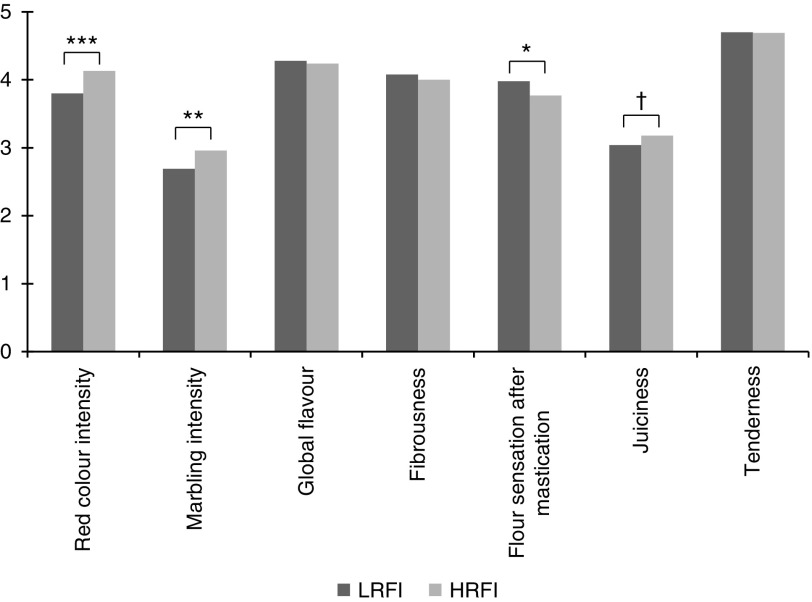
Sensorial meat quality in the loin evaluated on a 0 to 10 scale (none to very high)
in pigs from a low residual feed intake (RFI) line (LRFI, n=60) and
a high RFI line (HRFI, n=57) after seven generations of selection.
Red colour intensity and marbling intensity were appreciated on raw meat, the other
traits were appreciated on cooked meat (dry heat for 10 min at 250°C and then humid
heat at 100°C up to a core temperature of 80°C).
†0.05<P<0.1, *P<0.05,
**P<0.01, ***P<0.001. Adapted from
Faure et al. (2013).